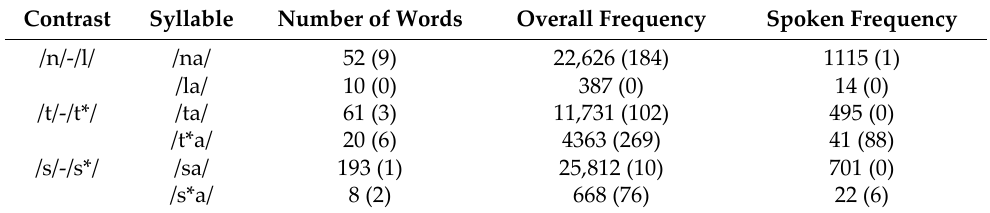
Table 1. Data from the NIKL corpus on words with the same first syllable as the stimulus items in Ahn et al. (2017). Data on words with a similar first syllable that includes a coda /k/ are included in